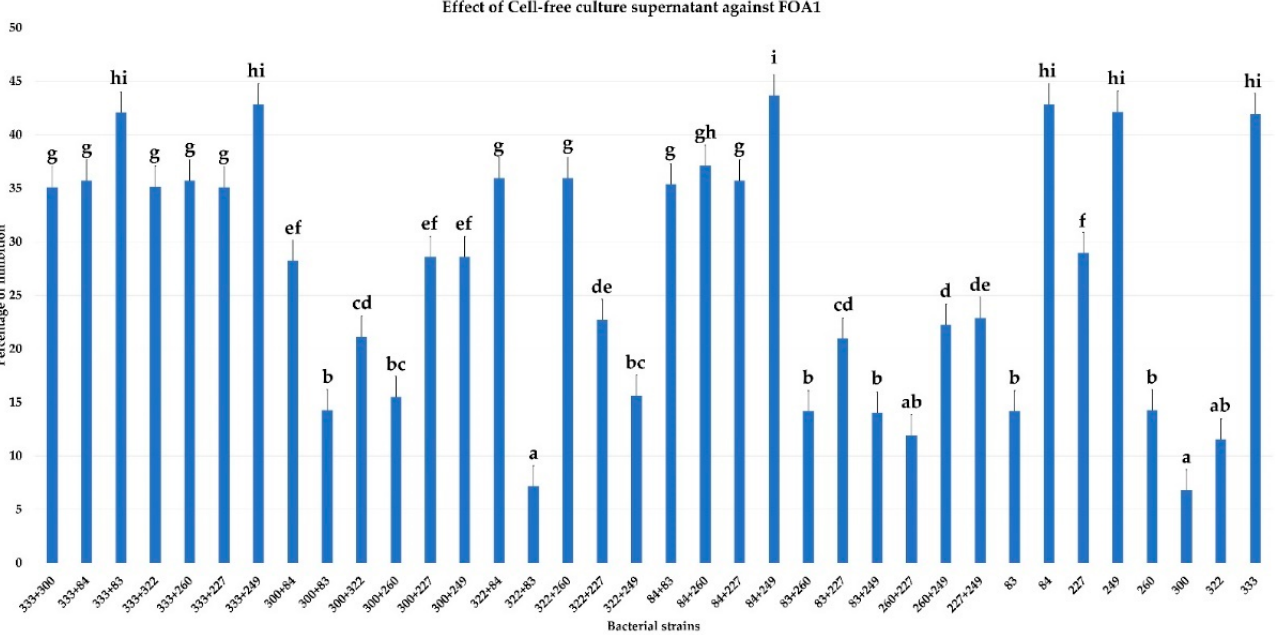
Figure 7. Percentage of inhibition of the cell-free culture supernatants of the bacterial strains alone or combined against FOA1. Data shown are the means ± the standard error. Different letters between bars in each group indicate a significant difference at ( p < 0.05) determined by ANOVA with the comparison of means using Tukey’s